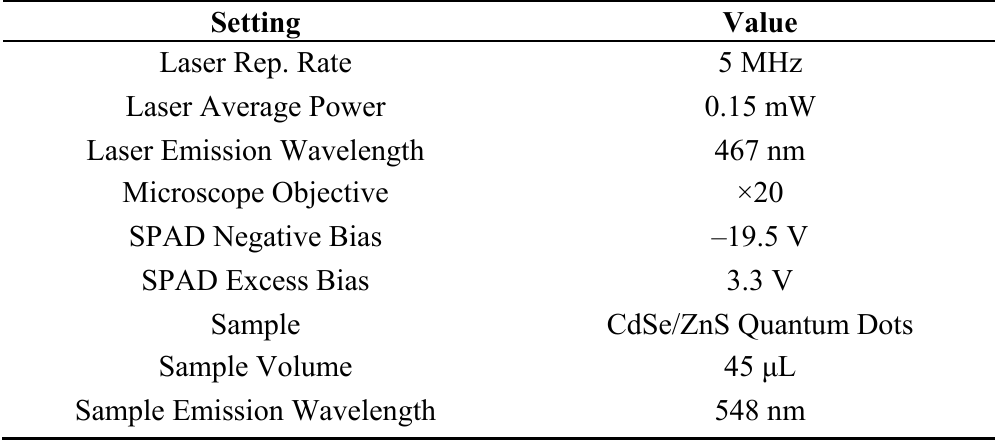
Table 2. An overview of the experimental setup used in limiting dilution tests.